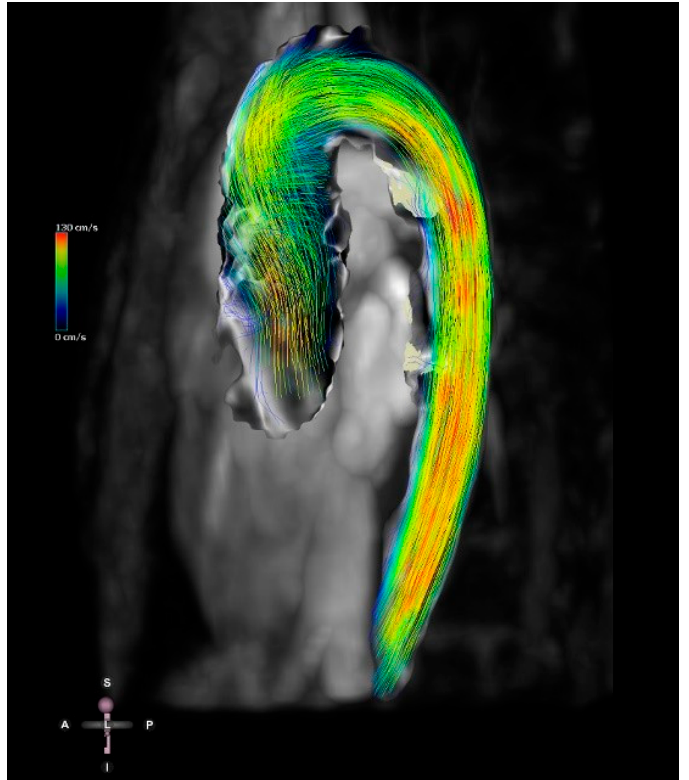
Figure 9. Four-dimensional flow image of a patient with a bicuspid aortic valve and dilation of the ascending aorta. Streamlines show the 4D flow dataset in mid-systole. Streamlines represent the direction of the flow and are colour-coded for velocity.